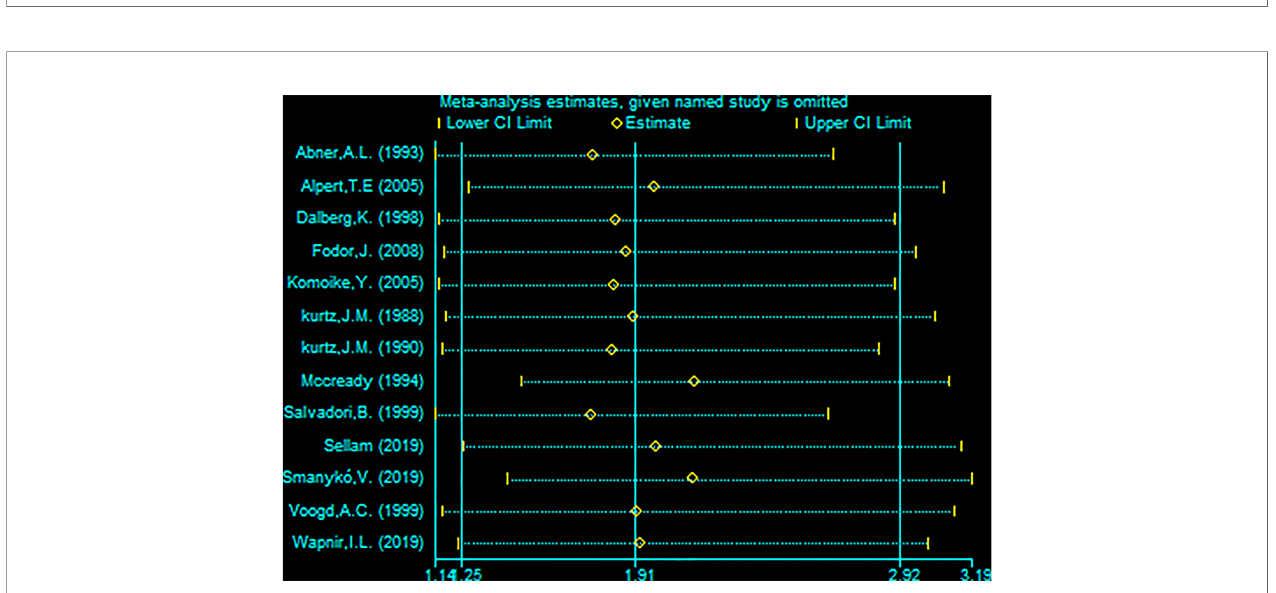
FIGURE 5 | Sensitivity analysis of meta-analysis of secondary local recurrence rate (SLRR) by the method omitting one